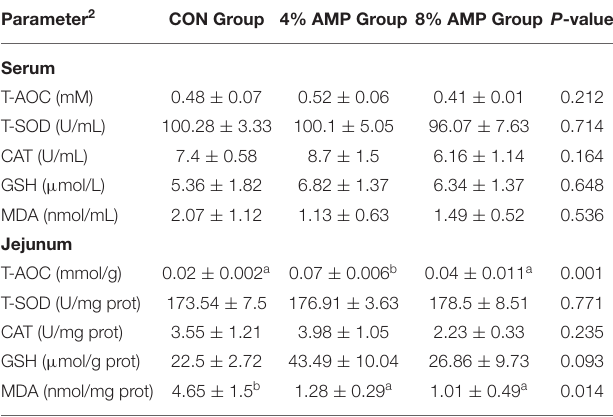
TABLE 5 | Effect of dietary AMP supplementation on antioxidant indexes in the serum and jejunum of pigs 1 . Parameter